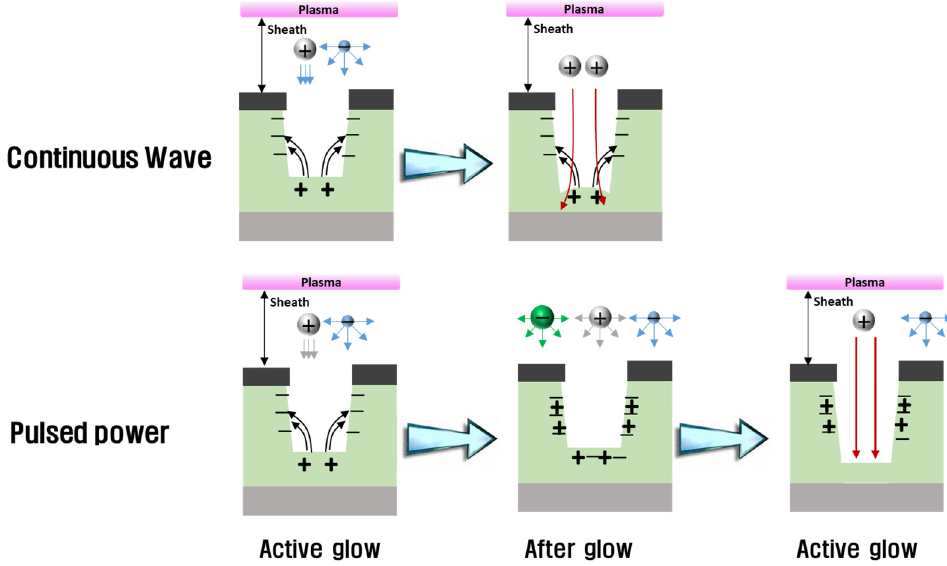
Figure 9. Micro-trench etching mechanism with continuous wave plasma and pulse-modulated plasma.